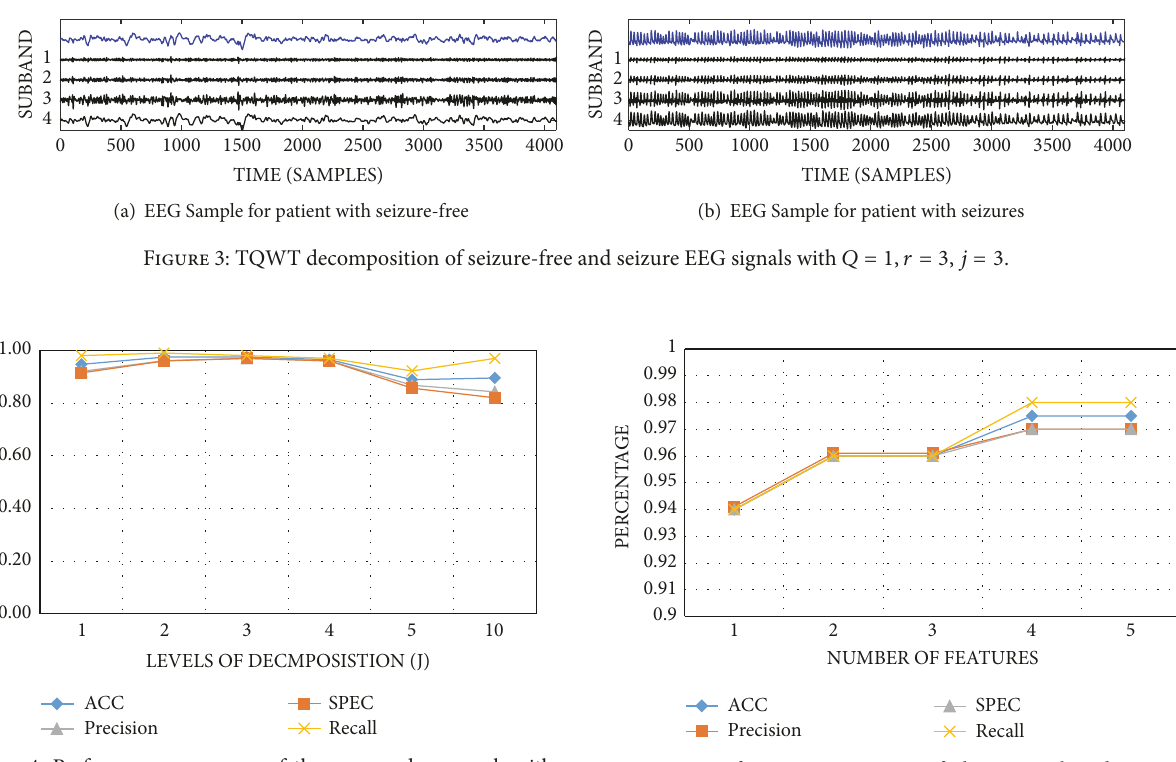
Figure 6: Performance measures of the original and compact features set.